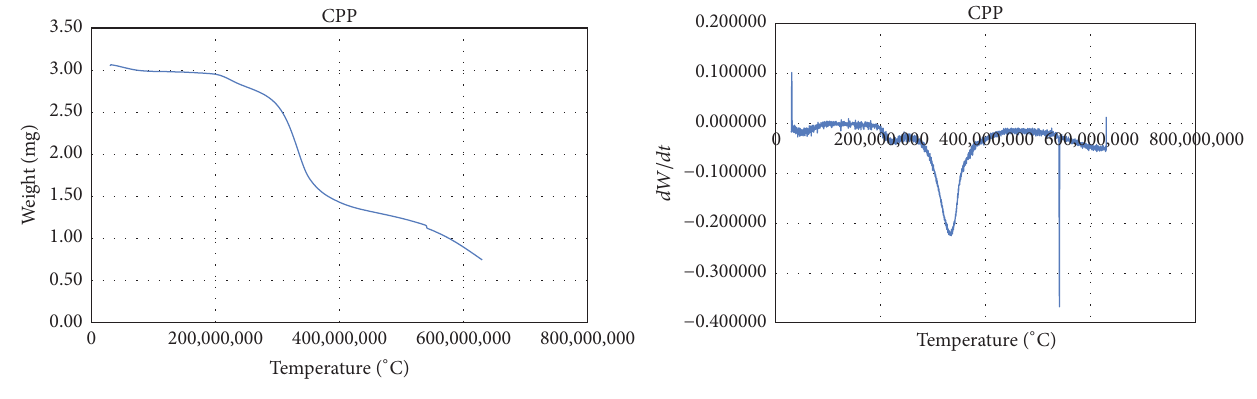
Figure 11: TGA/DTG curves of CPP.